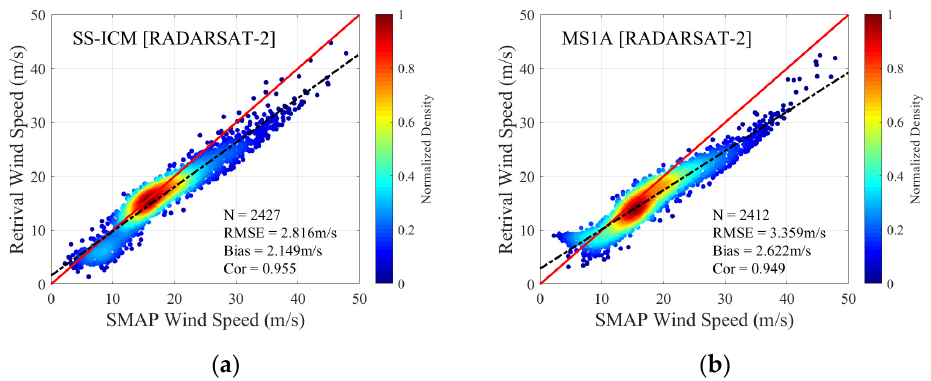
Figure 17. Comparisons of retrieved wind speeds from RS-2 SAR with collocated SMAP wind speeds. ( a ) SS-ICM model. ( b ) MS1A model.